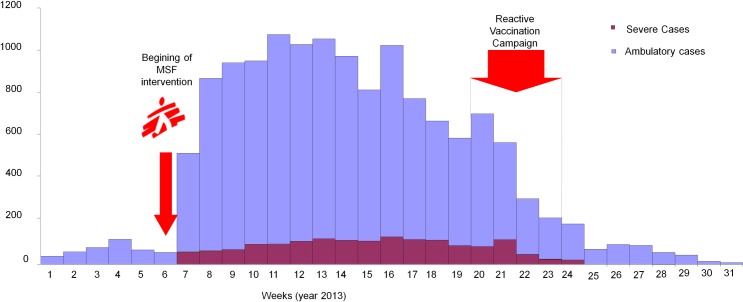
Suspected measles cases by week, Aketi Health Zone, Province Orientale, DRC, 2013 (source: MSF and MoH).